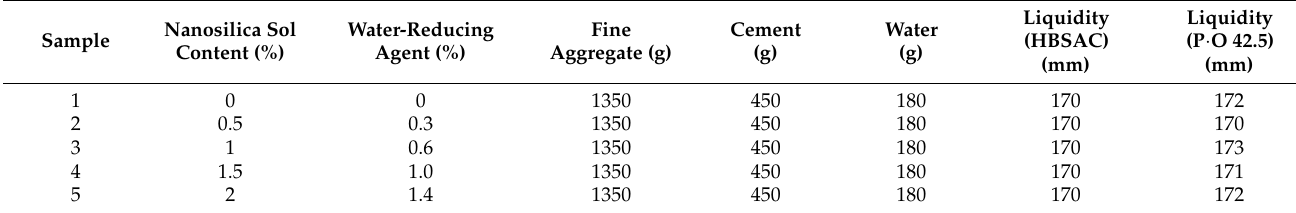
Table 2. Mix proportion design of